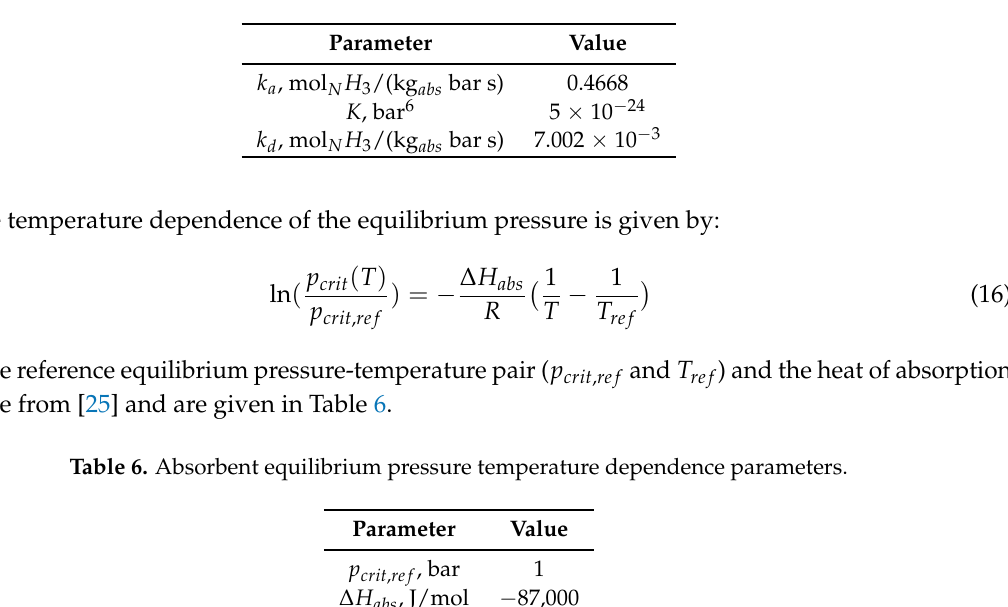
Table 5. Ammonia absorption and desorption rate parameters.